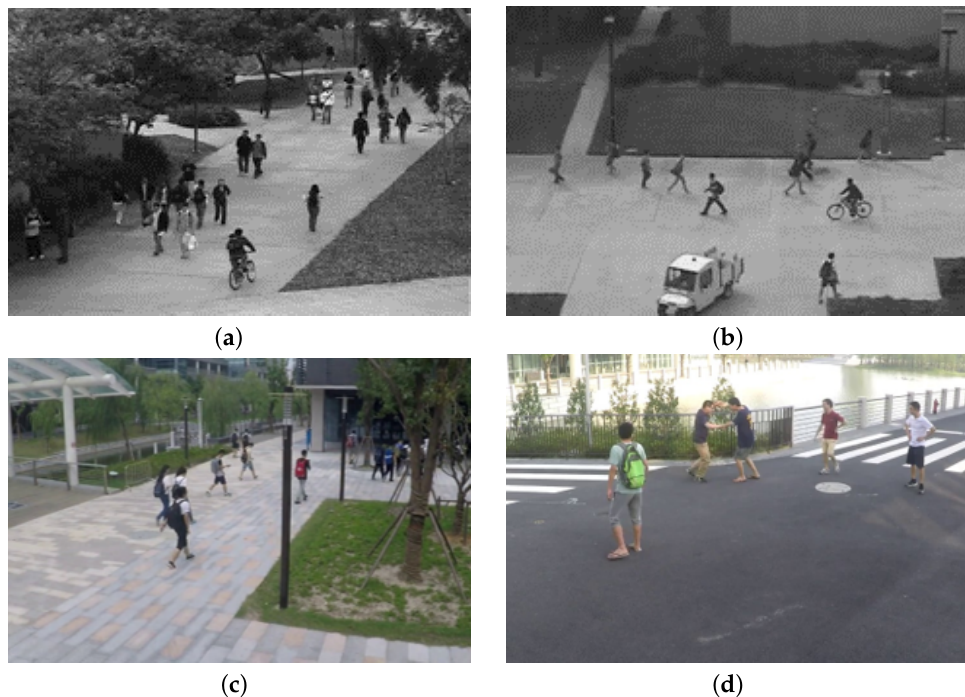
Figure 3. Abnormal frames extracted from widely used datasets for training and benchmarking video anomaly tasks. ( a ) Two bikers amongst the pedestrians in Ped1 [12] dataset. ( b ) Car and biker in a pedestrian walkway in Ped2 [12] dataset. ( c ) A normal frame from ShanghaiTech dataset [4]. ( d ) Two people fighting in ShanghaiTech dataset [4]